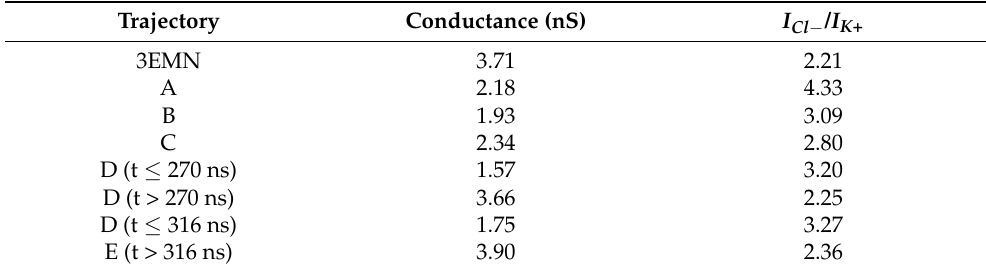
Table 1. Conductance and current ratio I Cl − / I K + measured for trajectories started from 3EMN and sampled subconducting conformers. For trajectories D and E, which show two conducting regimes, conductance and current ratio before and after the bifurcation point are